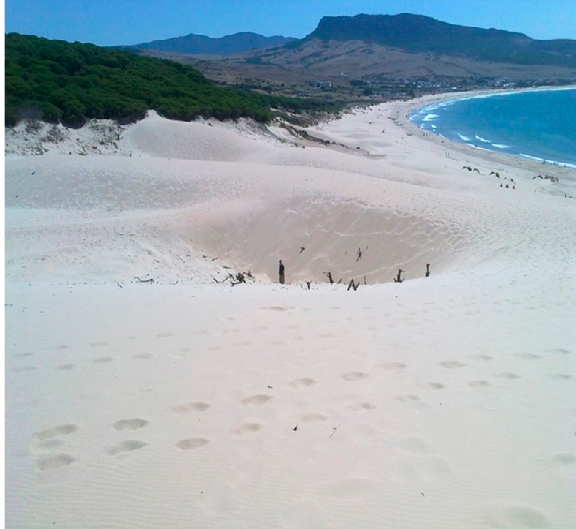
Fig. 8. – Deflation basins in the Bolonia dune. Note: A person is shown for scale.